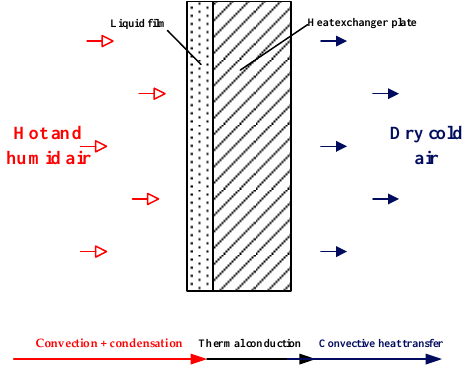
Figure 7. Schematic diagram of the condensing unit.